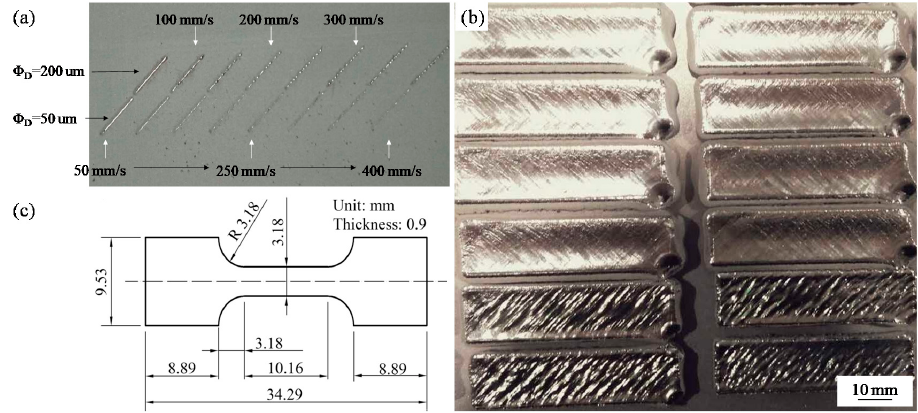
Figure 3. ( a ) Macrographs of single-scan tracks; ( b ) Macrographs of the Ti6-Al-4V samples; ( c ) Geometrical shape and size of a tensile test